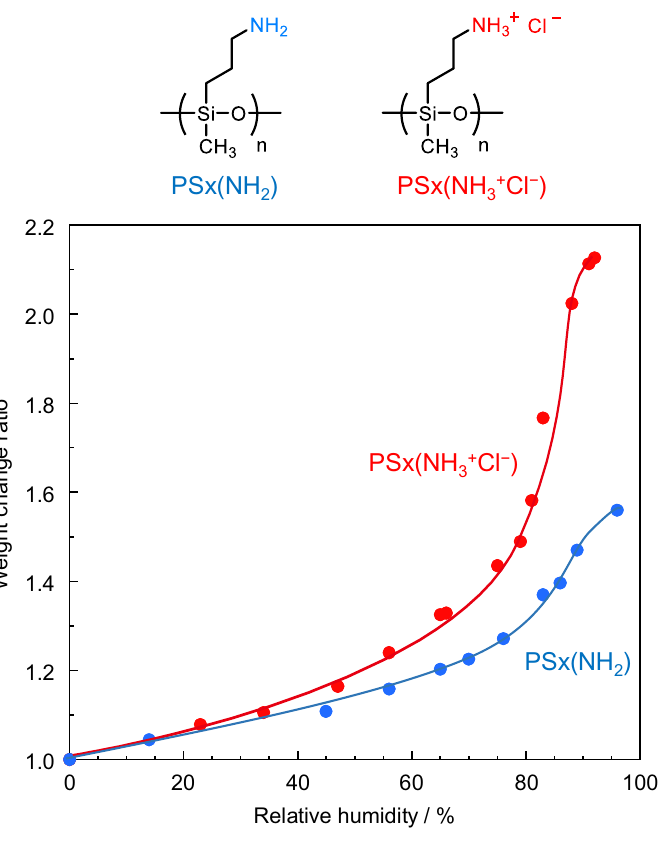
Figure 1. Chemical structures of polysiloxanes and the water vapor uptake amount (weight change ratio) of the polysiloxanes against the relative